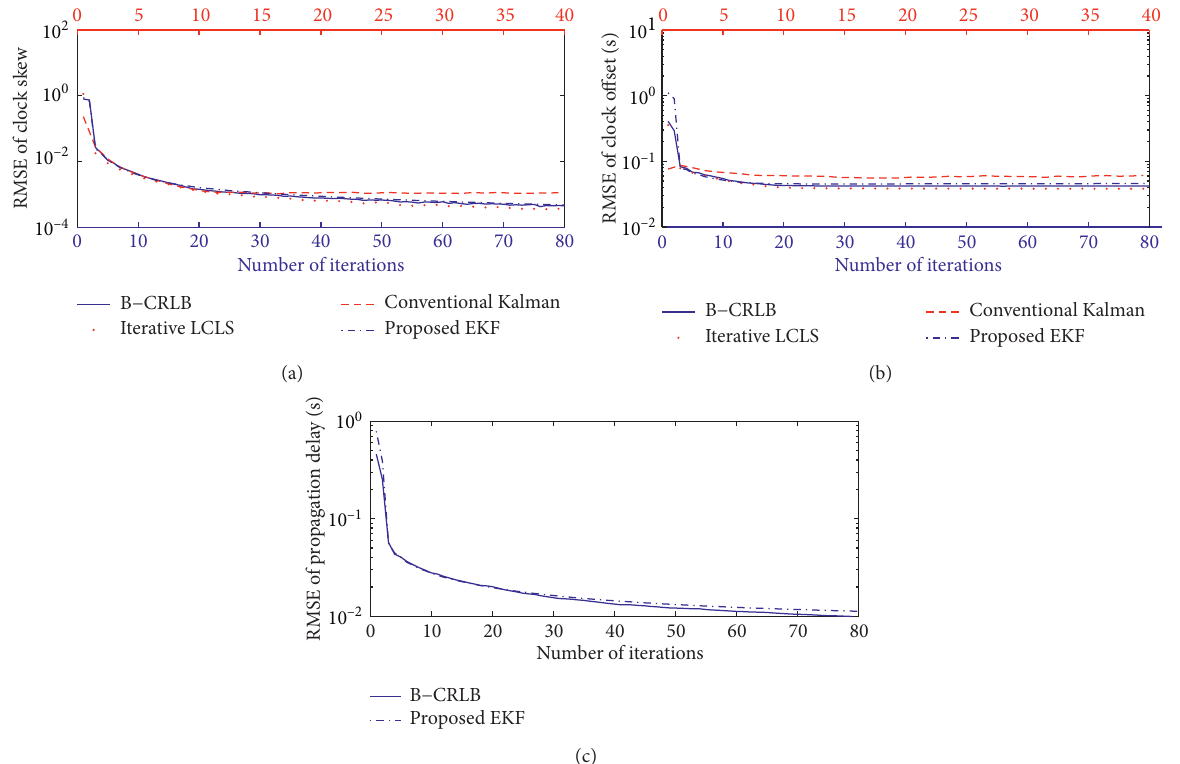
Figure 2: RMSEs of the estimated clock skew ω j (a), offset ϕ j (b), and propagation delay τ i,j (c) with respect to the number of iterations.